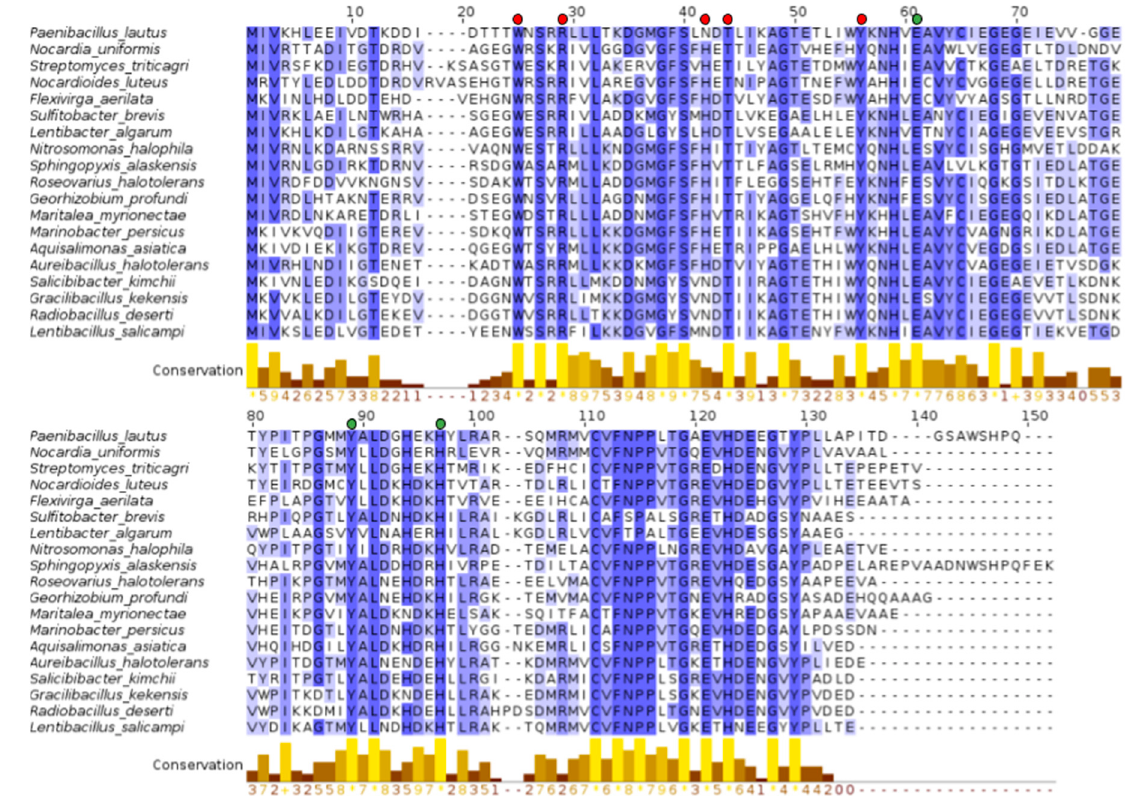
Figure 3. Multiple sequence alignment (MSA) of randomly selected EctC protein sequences from the UniProt database [25], obtained with the Clustal Omega programme [26] and visualised with JalView [27]. The MSA result is coloured according to the amino acid conservation: from the most conserved residues (dark blue) to the least conserved (white). Red dots indicate the residues participating in substrate binding, while green dots indicate the metal-binding amino acids. Below the MSA is the conservation section prepared with JalView, which scales from 0 (deep brown) to 10 (bright yellow) the conservation of physio-chemical properties in the